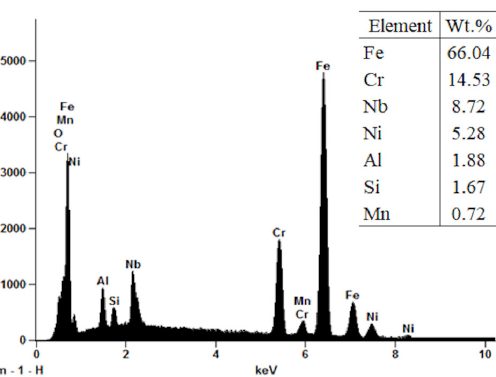
Figure 8. Spectrum features of energy to the elements in coating. Significant presence of Fe, Cr, Nb, Ni, Al, Mn and Si, in a semi- quantitative method, the elements being in accordance with wires used.